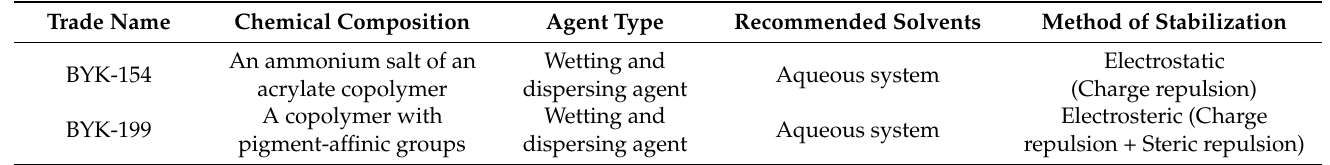
Table 1. Properties of the dispersants.